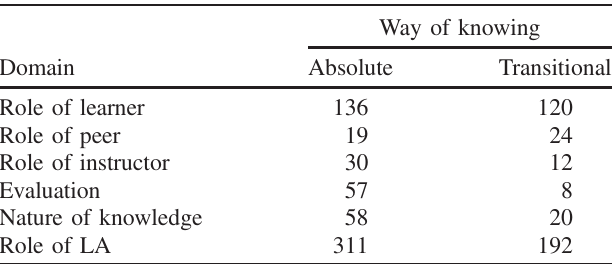
TABLE VI. Overview of the different ways of knowing described in the epistemological reflection